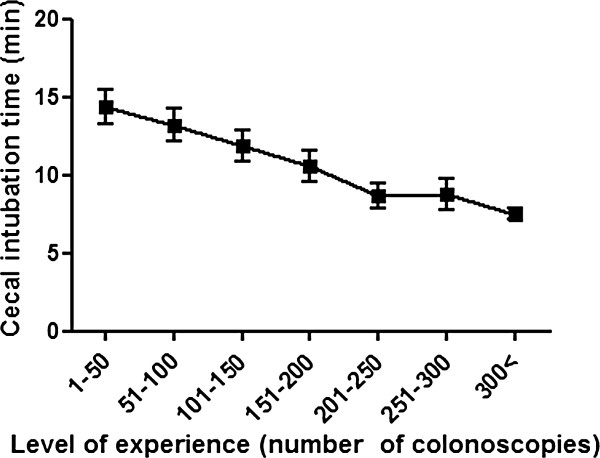
Cecal intubation time learning curves. The learning curve for average cecal intubation times is shown. (Error bars represent the 95% confidence interval). A significant inverse correlation between cecal intubation times and level of experience is shown.